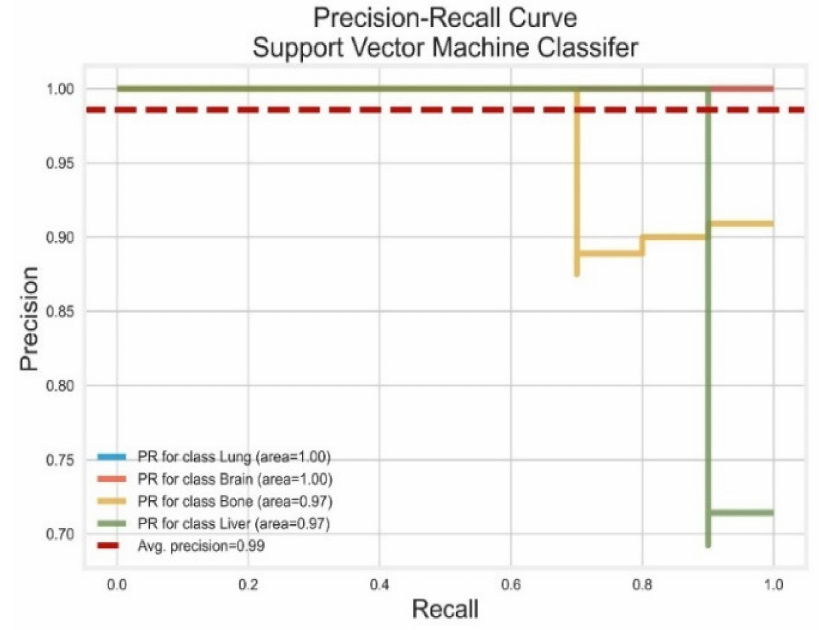
Figure 27. Precision-Recall Curve (Support Vector Machines).